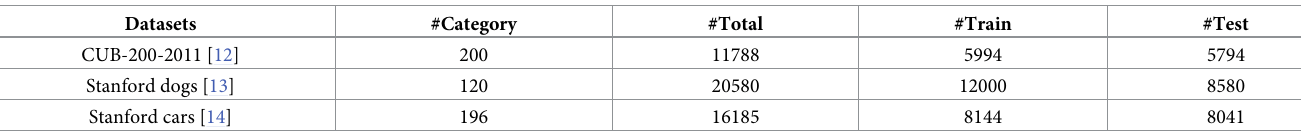
Table 2. Details of the three